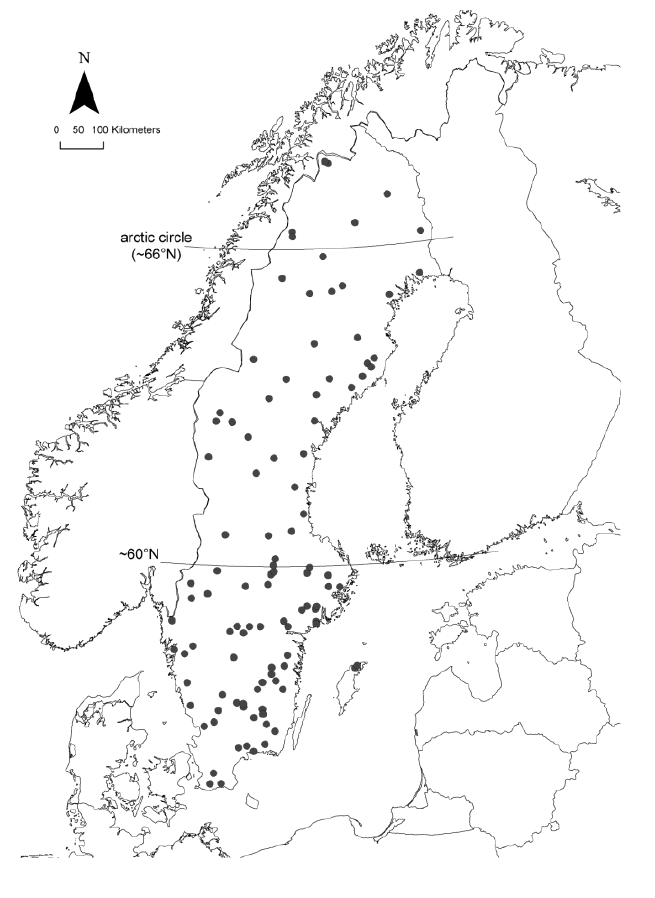
Figure 1. Map of Sweden showing the location of the lakes used in the